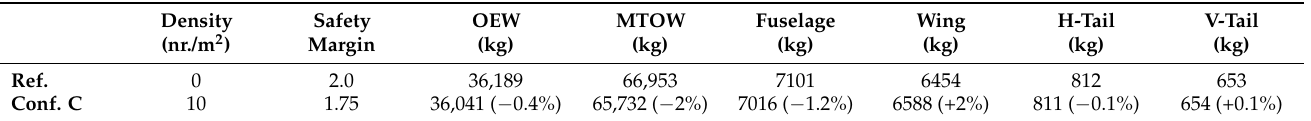
reference (without SHM and with SM = 2.0).